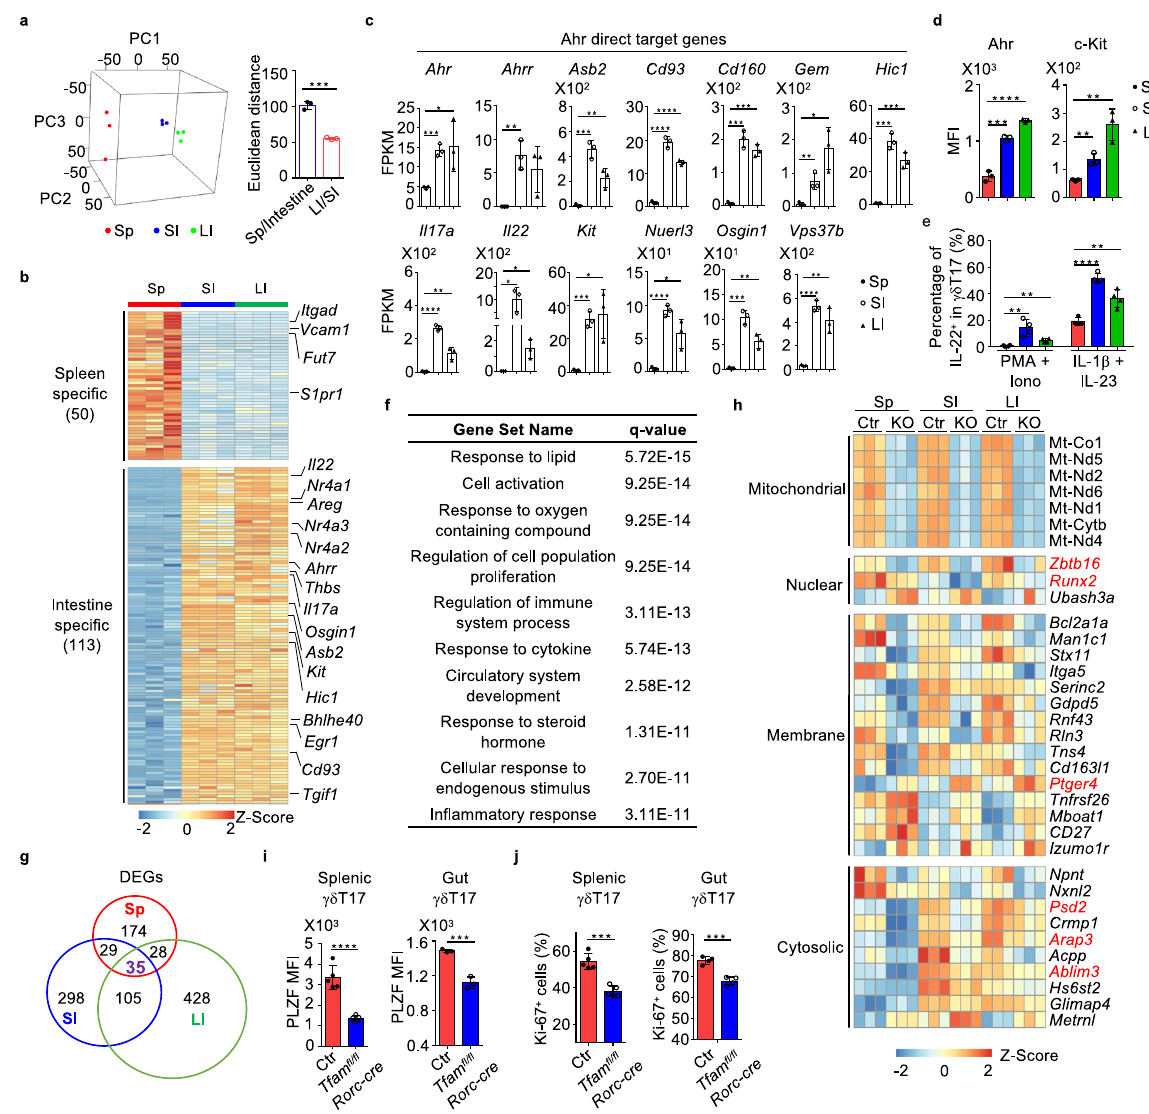
Fig. 4 Gene pro fi ling reveals tissue-speci fi c transcriptomic signature of γδ T17 cells. a Left panel, principal component analysis (PCA) plot of the RNA-seq of Tfam-suf fi cient splenic (Sp), small intestinal (SI), and large intestinal (LI) γδ T17 cells from 3-week-old ( n = 3 for each group) mice. γδ T17 cells of each sample were sorted from an individual mouse. Right panel, Euclidean distance comparison of the transcriptome of each splenic γδ T17 cell sample and the mean intestine centroid vs. the mean small intestine centroid to each large intestinal γδ T17 cell sample ( n = 3 for each group) (*** P = 0.0002). b Heatmap of tissue-speci fi c genes (TSGs) identi fi ed by the RNA-seq in Sp, SI, and LI γδ T17 cells. Genes were ranked in a descending order based on the fold changes of expression (Sp/[SI and LI average mean]; [SI and LI average mean]/Sp). c RNA-seq FPKM values of Ahr direct target genes of Sp, SI, and LI γδ T17 cells (mean ±SD) ( n = 3 for each group) (Sp vs. SI: Ahr , *** P = 0.0005, Ahrr , ** P = 0.0037, Asb2 , *** P = 0.0004, Cd93 , **** P <0.0001, Cd160 , *** P = 0.0002, Gem , ** P = 0.0096, Hic1 , *** P = 0.0002, Il17a , **** P < 0.0001, Il22 , * P = 0.0180, Kit , *** P = 0.0004, Nuerl3 , **** P < 0.0001, Osgin1 , *** P = 0.0002, Vps37b , **** P < 0.0001; Sp vs. LI: Ahr , * P = 0.0460, Ahrr , P = 0.0506, Asb2 , ** P = 0.0076, Cd93 , **** P < 0.0001, Cd160 , *** P = 0.0001, Gem , * P = 0.0108, Hic1 , *** P = 0.0008, Il17a , ** P = 0.0071, Il22 , * P = 0.0171, Kit , * P = 0.0166, Nuerl3 , * P = 0.0137, Osgin1 , ** P = 0.0027, Vps37b , ** P = 0.0034). FPKM, fragments per kilobase of exon model per million mapped fragments. d Ahr and c-Kit expression in Sp, SI, and LI γδ T17 cells by fl ow cytometry ( n = 4 for each group) (Sp vs. SI: Ahr, *** P = 0.0003, c-Kit, ** P = 0.0049; Sp vs. LI: Ahr, **** P < 0.0001, c-Kit, ** P = 0.0039). Compiled data from one experiment. e Percentages of IL-22 + cells in Sp, SI, and LI γδ T17 cells by fl ow cytometry ( n = 4 for each group) (Sp vs. SI: PMA + Iono, ** P = 0.0046, IL-1 β + IL-23, **** P < 0.0001; Sp vs. LI: PMA + Iono, ** P = 0.0021, IL-1 β + IL-23, ** P = 0.0027). Cells were stimulated with or without PMA (20ng/ml) plus ionomycin (Iono) (1 μ g/ml) but with IL-1 β (10ng/ml) plus IL-23 (10ng/ml) for 6 h. Compiled data from one experiment. f GO analysis of the 113 TSGs in γδ T17 cells. g Pie graph of differentially expressed genes (DEGs) between Ctr and Tfam-de fi cient γδ T17 cells from Sp, SI, and LI. h Heatmap of the 35 core Tfam-regulated DEGs in γδ T17 cells. KO indicated Tfam fl / fl Rorc-cre mice. i Left panel, PLZF expression in splenic γδ T17 cells from mice with indicated genotypes by fl ow cytometry ( n = 5 for each group) (splenic, **** P < 0.0001; gut, *** P = 0.0008). Compiled data from two independent experiments. Right panel, PLZF expression in gut γδ T17 cells from mice with indicated genotypes by fl ow cytometry ( n = 3 for each group). Compiled data from one experiment. j Left panel, Ki-67 expression in splenic γδ T17 cells from 3-week-old mice with indicated genotypes by fl ow cytometry ( n = 5 for each group) (spleen, *** P = 0.0001; gut, *** P = 0.0003). Compiled data from two independent experiments. Right panel, Ki-67 expression in gut γδ T17 cells from 1-week-old mice with indicated genotypes by fl ow cytometry ( n = 4 for each group). Compiled data from one experiment. Ctr included Tfam fl / fl , Tfam + / + Rorc-cre , and Tfam fl / + Rorc-cre mice in g – j . Data are shown as mean± SD in a , c – e , i , j . NATURE COMMUNICATIONS| (2021) 12:4462 |https://doi.org/10.1038/s41467-021-24755-9|www.nature.com/naturecommunications